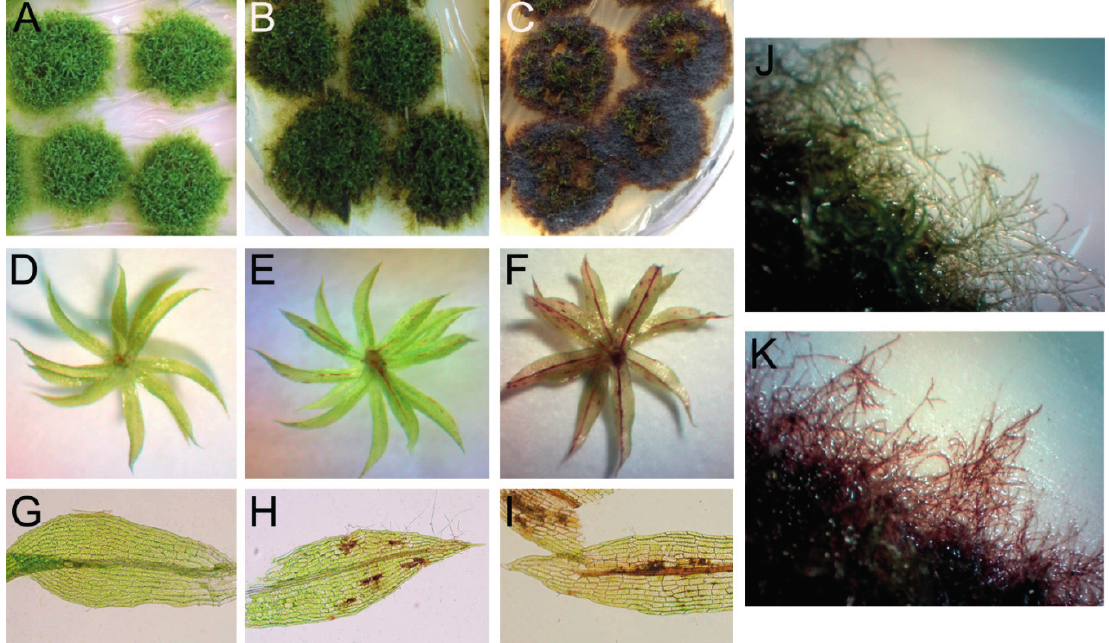
Figure 2. Symptom development in C. gloeosporioides inoculated P. patens tissues. ( A ) Control moss colonies; ( B ) C. gloeosporioides infected moss colonies at 2 days after inoculation (DAI); ( C ) C. gloeosporioides infected moss colonies at 5 DAI; ( D ) Control gametophore; ( E ) C. gloeosporioides infected gametophore at 2 DAI; ( F ) C. gloeosporioides infected gametophore at 5 DAI; ( G ) control leaf; ( H ) C. gloeosporioides infected leaf at 2 DAI; ( I ) C. gloeosporioides infected leaf at 5 DAI; ( J ) Border of a control moss colony; ( K ) Border of a moss colony inoculated with C. gloeosporioides at 5 DAI. In D , E and F gametophores were cut at the lower part of the cauloid and placed upside down for proper visualization of